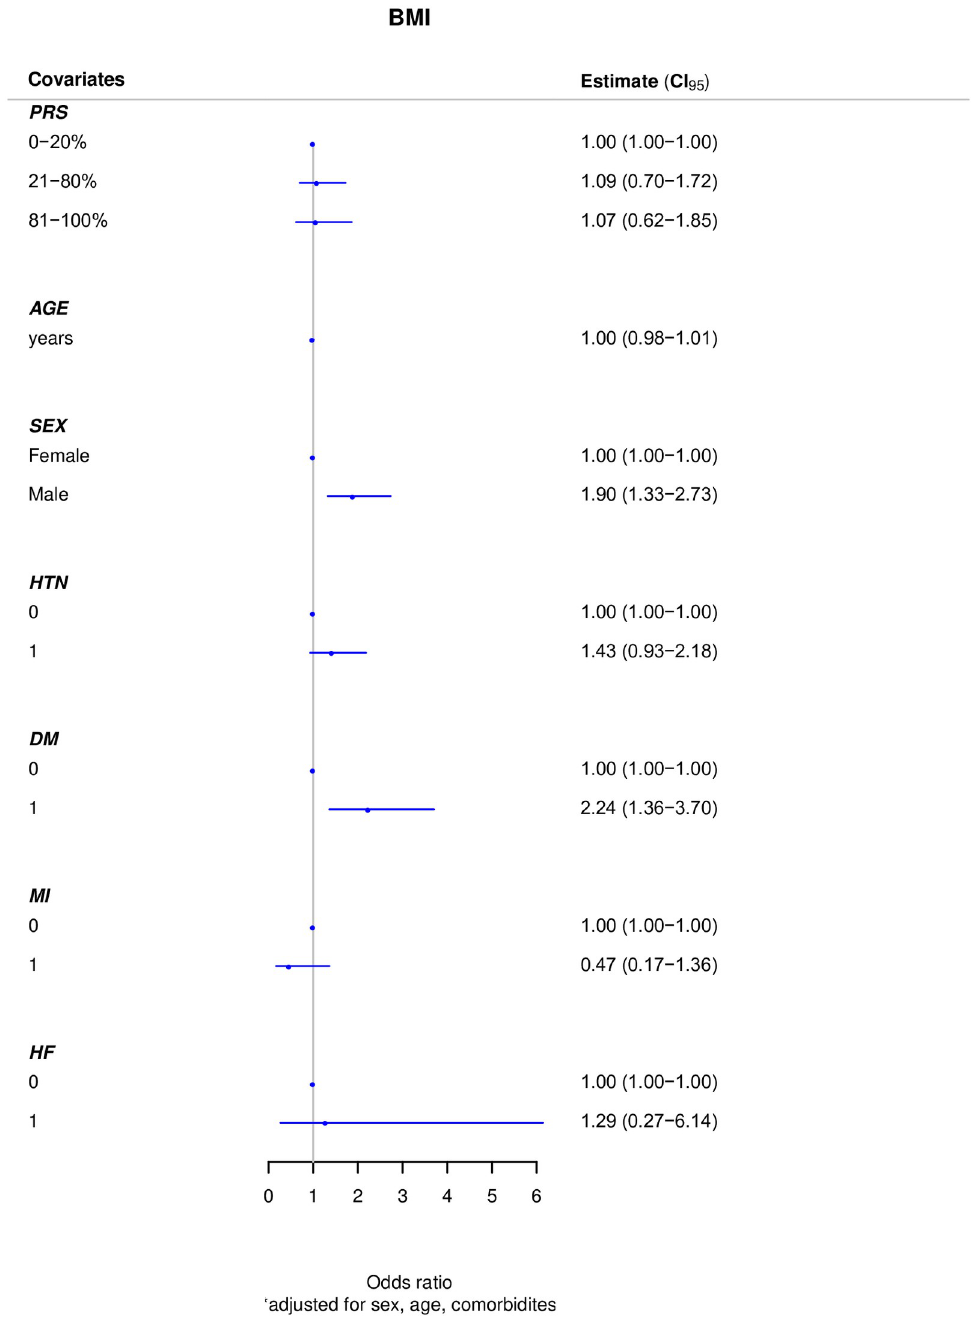
Fig 2. Adjusted polygenic risk score for BMI groups in Hispanics/Latinos. Abbreviations: BMI, body mass index; CI, confidence interval; HTN, hypertension; DM, diabetes mellitus; MI, myocardial infarction; HF, heart